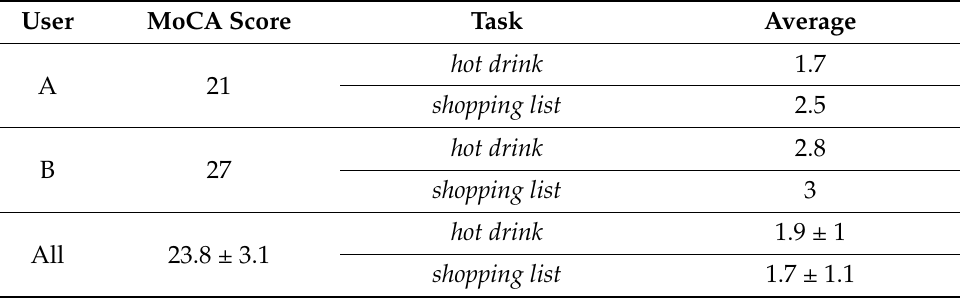
Table 3. Comparison of self-questionnaire for case study users and All